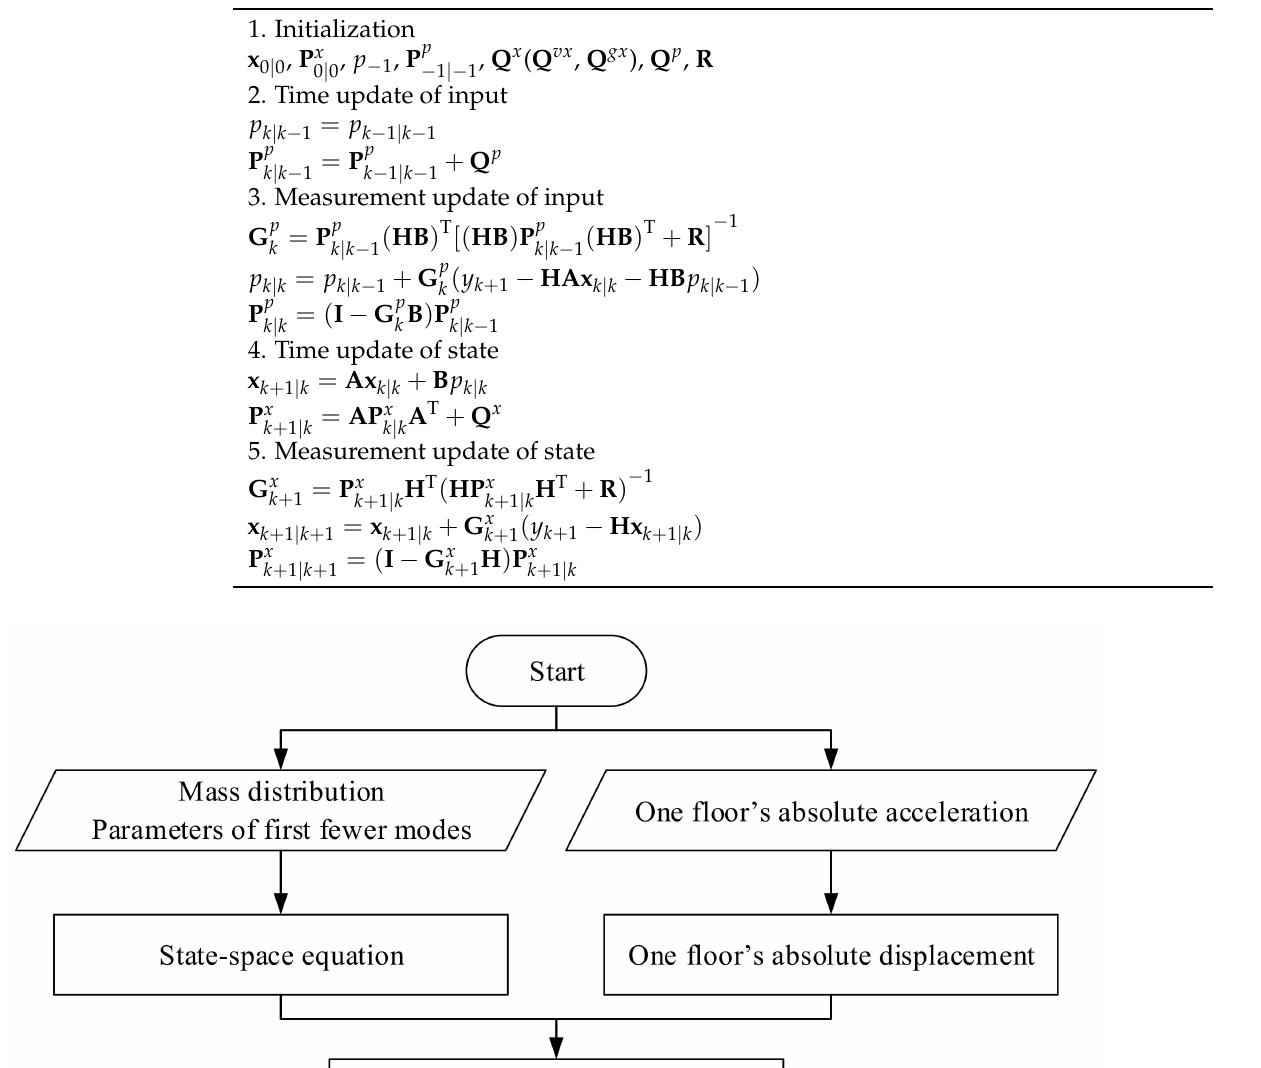
Table 1. Two-stage filter for the input and state estimation.